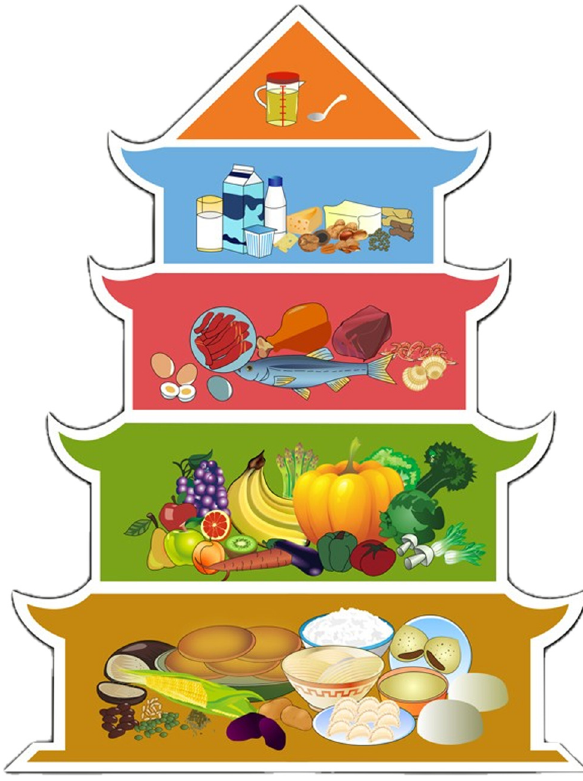
Figure 7: Application of UCNPs in food safety detection based on diet pagoda; the fi rst layer is cereal and potato food: UCNPs can be used to detect mycotoxins. The second layer is fruits and vegeta - bles: UCNPs can be used to detect pesticide residues. The third layer is fi sh, poultry, meat, eggs, and other animal foods: UCNPs can be used to detect food - borne pathogens, antibiotics, veterinary drug residues, and heavy metals. The fourth layer is milk, soybeans and nuts: UCNPs can be used to detect food - borne pathogens, bacterial toxins, mycotoxins, antibiotics, hormones, and prohibited additives. The fi fth layer is cooking oil and salt: UCNPs can be used to detect